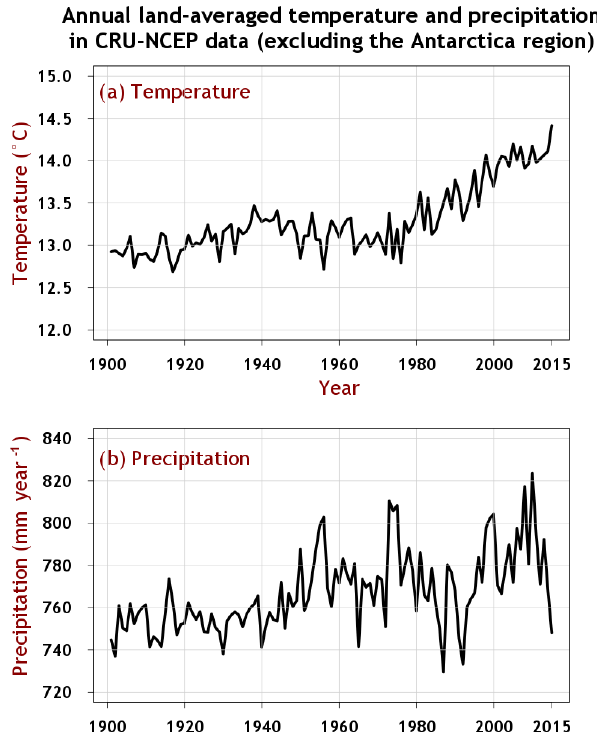
Figure B1. Annual land-averaged temperature and precipitation in version 7 of the CRU-NCEP data for the period 1901–2015, excluding the Antarctica region, that are used to drive the CLASS-CTEM model.